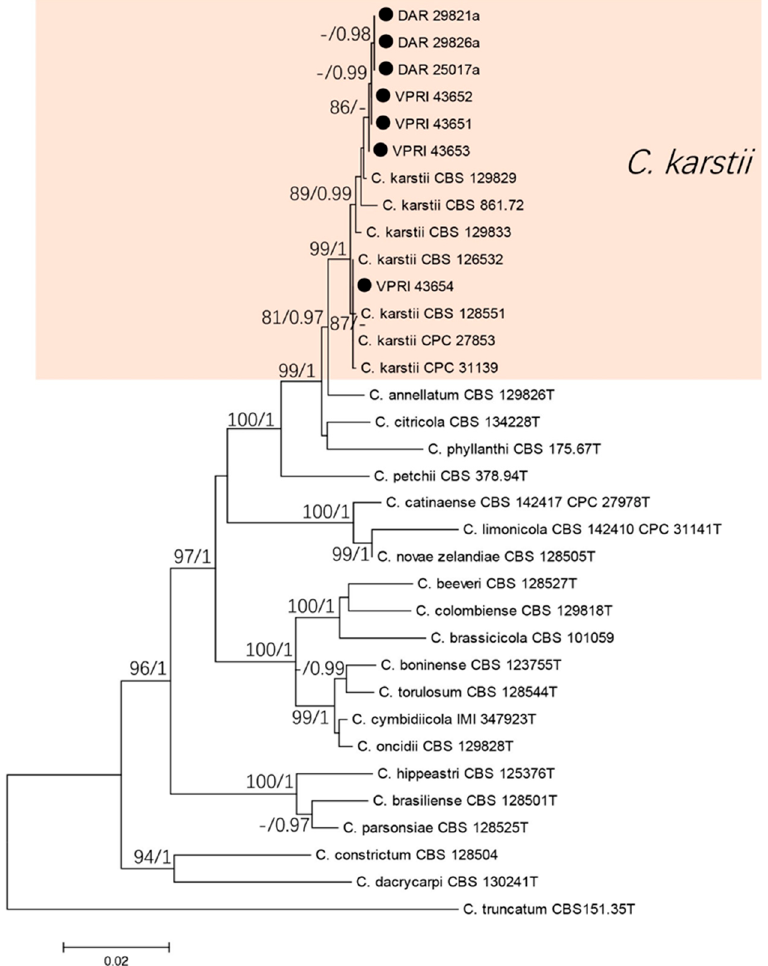
Figure 3. Phylogenetic analysis of the combined ITS, tub2 , act , chs-1 , and his3 sequence alignment of Colletotrichum isolates in the boninense complex. The bootstrap support values (ML > 75%) of maximum likelihood analysis and Bayesian posterior probabilities (PP > 0.90) are displayed at the nodes (ML/PP). Black circle denotes isolates from Citrus